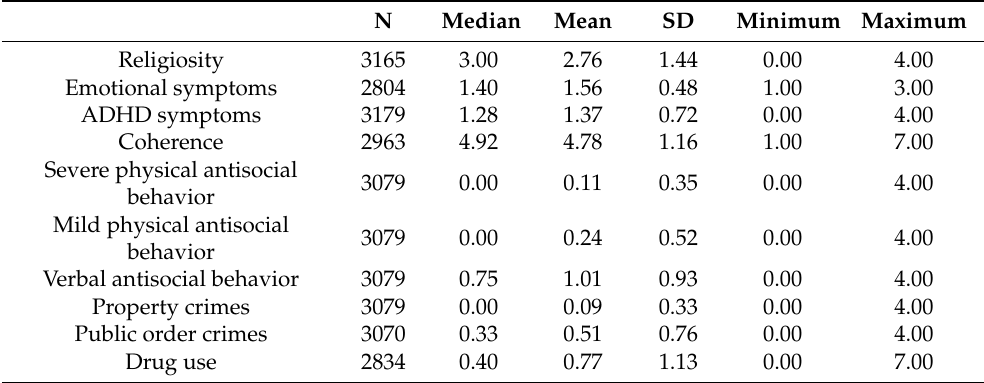
Table 1. Descriptive statistics of the demographic characteristics, ADHD, and antisocial behavior